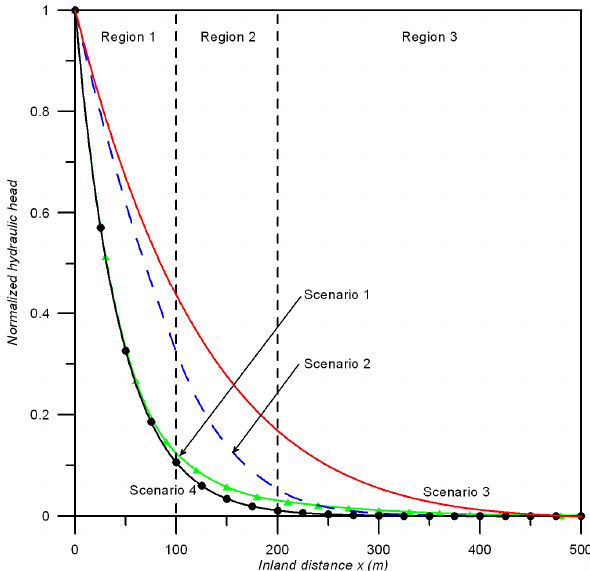
Figure 6. The spatial head distributions in the lower aquifer with heterogeneous trending 2 Fig. 6. The spatial head distributions in the lower aquifer with het- erogeneous trending aquitards for scenarios 1 and 2 and with ho- aquitards for scenarios 1 and 2 and with homogeneous aquitards but having different 3 mogeneous aquitards but having different conductivity values for conductivity values for scenarios 3 and 4 at high-tide period ( πω 2 = t scenarios 3 and 4 at high-tide period ( ωt = 2 π ).